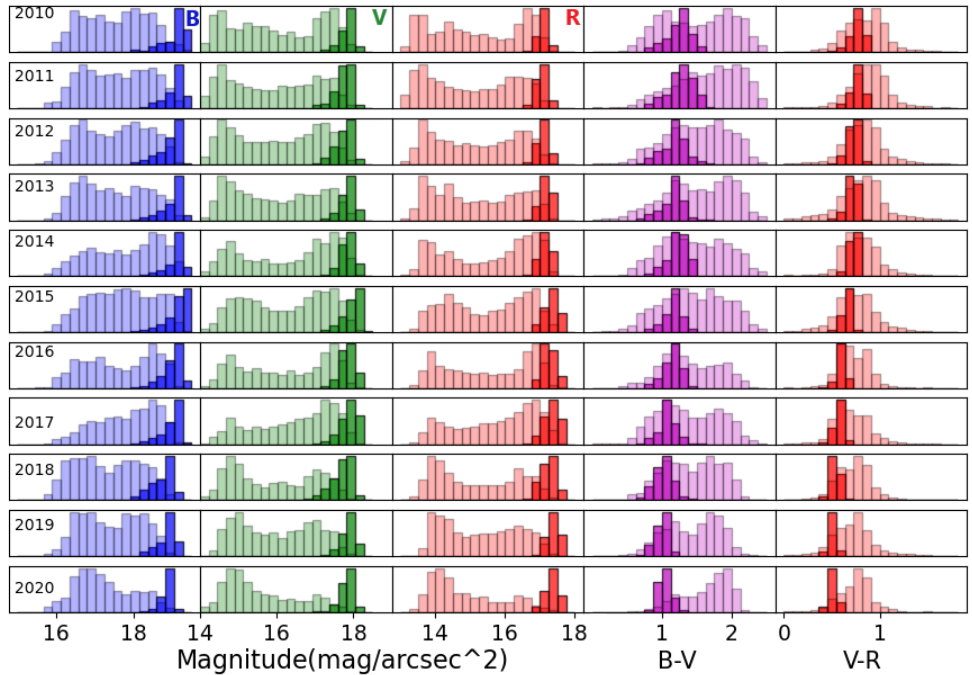
Figure 7. AstMon. From left to right, histograms for the Johnson B, V, R, B-V, and V-R color indices for the whole dataset, grouped by year. Darker bars are for filtered data (no moon over the horizon and no clouds) and lighter bars for unfiltered data (with moon and clouds).